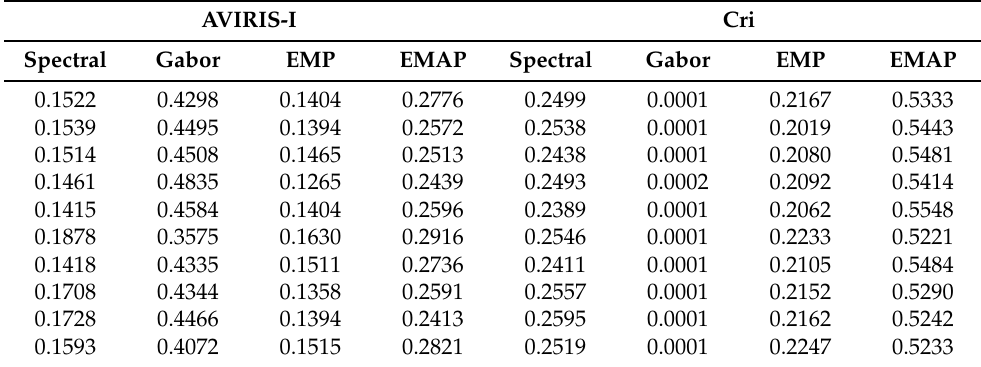
Table 3. Ten groups of weight for the four features on AVIRIS-I and Cri